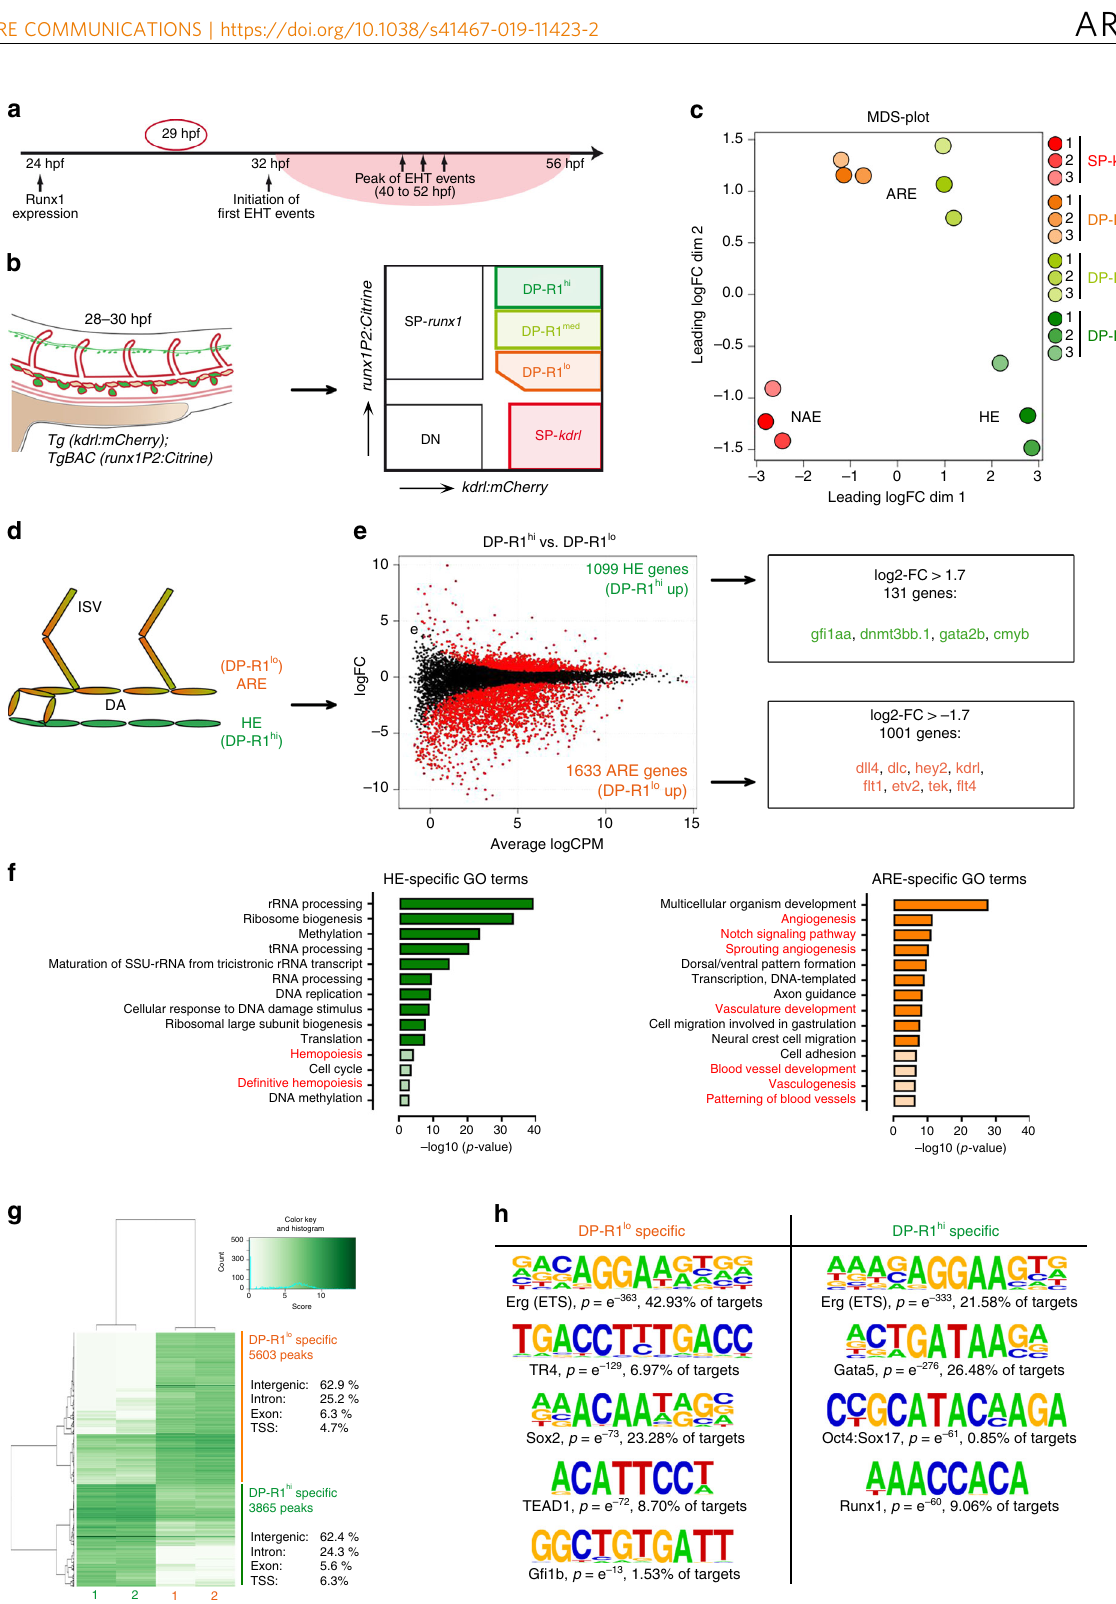
While most HE markers, cmyb , gata2b and g fi 1aa 23,27,28 were part of Cluster 2, the previously identi fi ed HE-speci fi c gene dnmt3bb.1 29 was not. To identify the most meaningful set of HE- speci fi c genes we performed DEG analysis between the closely related HE (DP-R1 hi ) and ARE (DP-R1 lo ) (Fig. 3d, e),